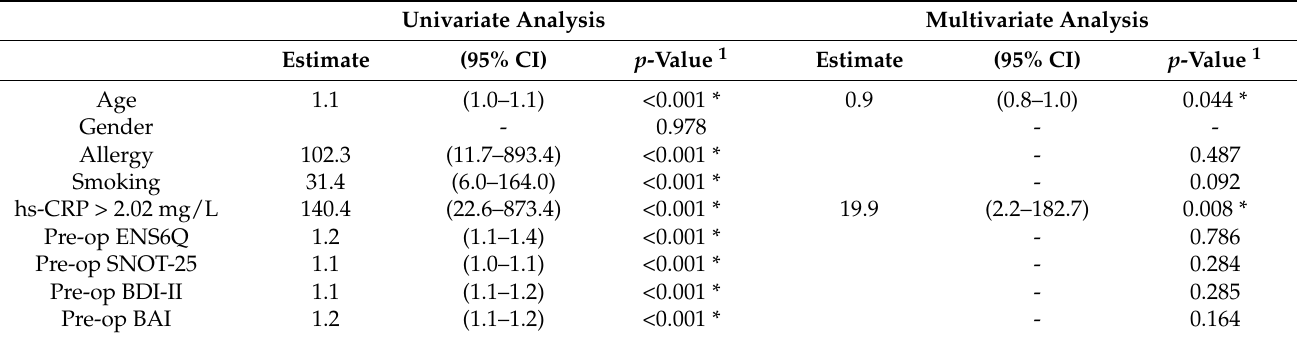
Table 4. Logistic regression analysis of postoperative depression status and other potentially associated